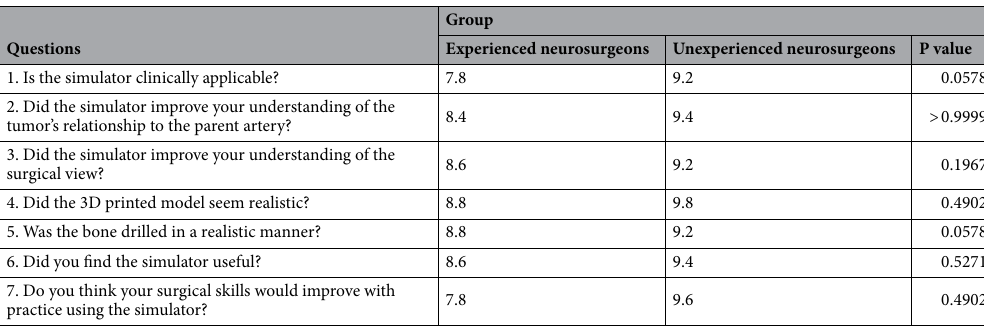
Table 2. Average scores of the questionnaire used by experienced and unexperienced neurosurgeons to evaluate the 3D printed model (scores range from 1 to